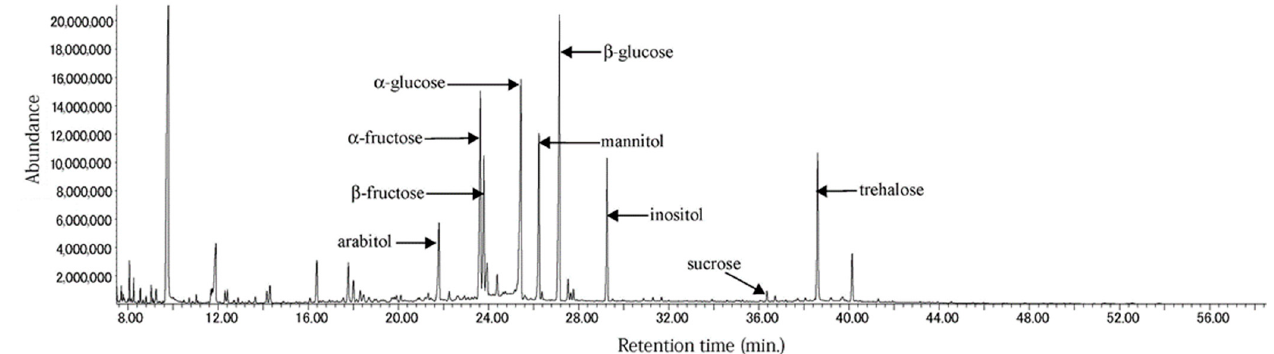
Figure 4. Typical GC/MS trace (TIC chromatogram) of sugar compounds isolated from nighttime aerosol sample (sampling dates, 9 to 13 September 2017) from Namie-cho, Fukushima.